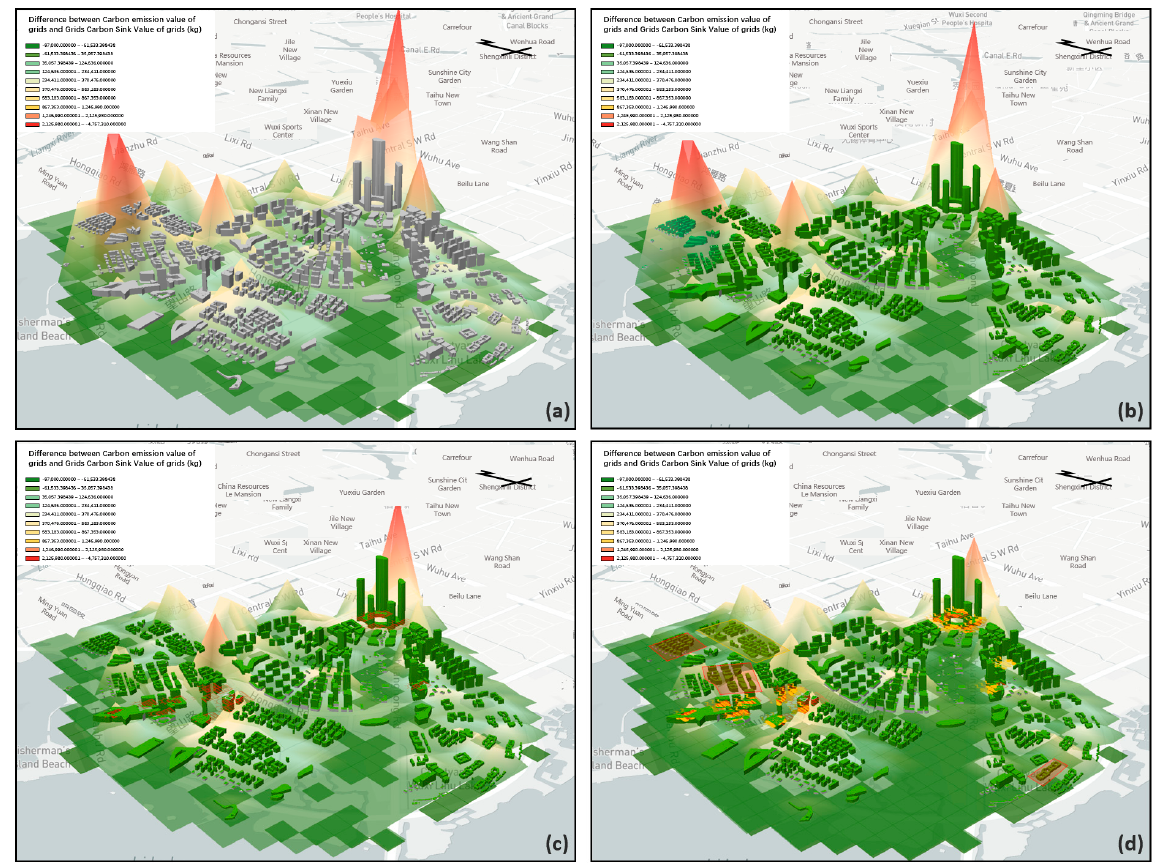
Figure 12. Carbon emission and carbon sink distribution of Lihu Future City design scheme: ( a ) Initial Carbon Sink and Carbon Emission, ( b ) Diagram of green roof interventions and three-dimensional greening intervention, ( c ) Diagram of the overlay of green roof interventions, three-dimensional green interventions and solar panel interventions, ( d ) Overlay diagram of green roof interventions, three-dimensional green interventions, solar panel interventions, ground source heat pump interventions and transformation of industrial industries and waterfront commercial areas into research and experimental industrial areas (Visualization based on mapbox platform).